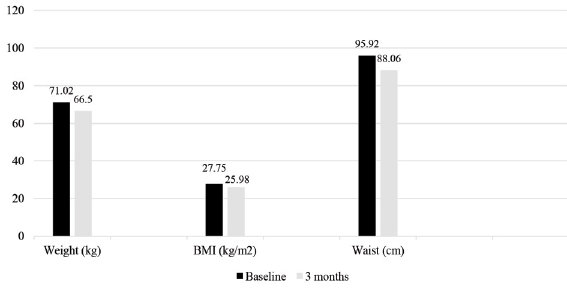
Figure 1: Mean of anthropometric measurements at the baseline and 3 months